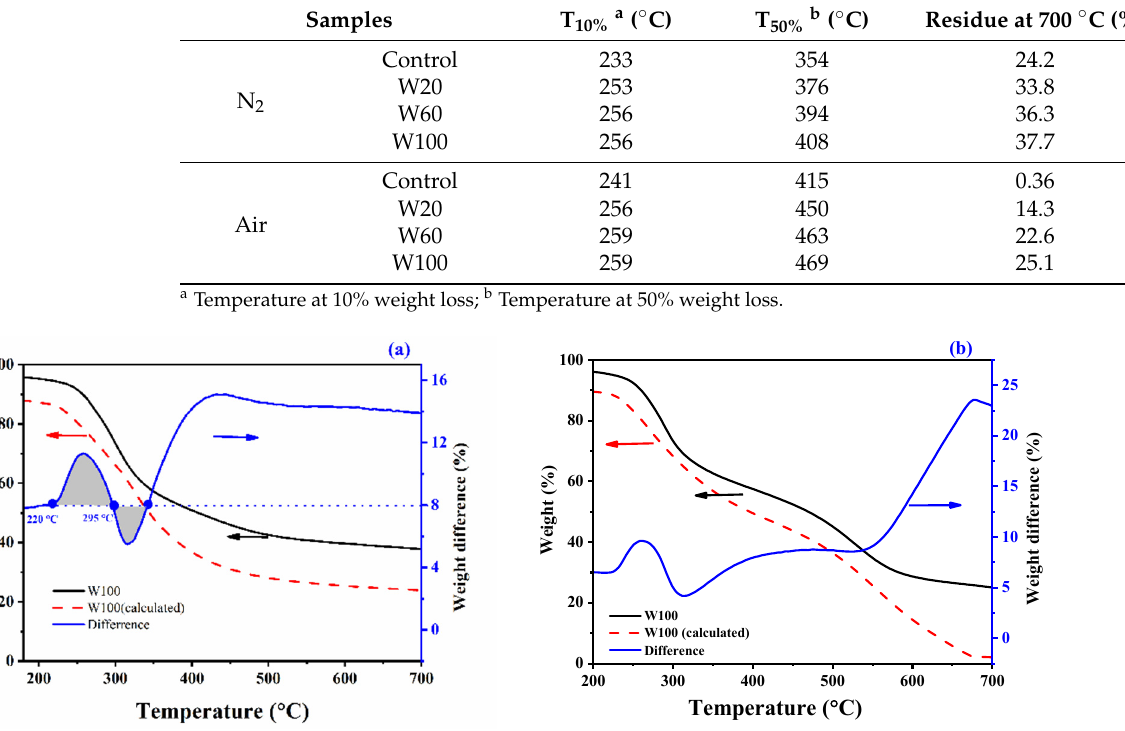
Table 2. TG data of PBTCA-treated and control wool fabrics in nitrogen and air.